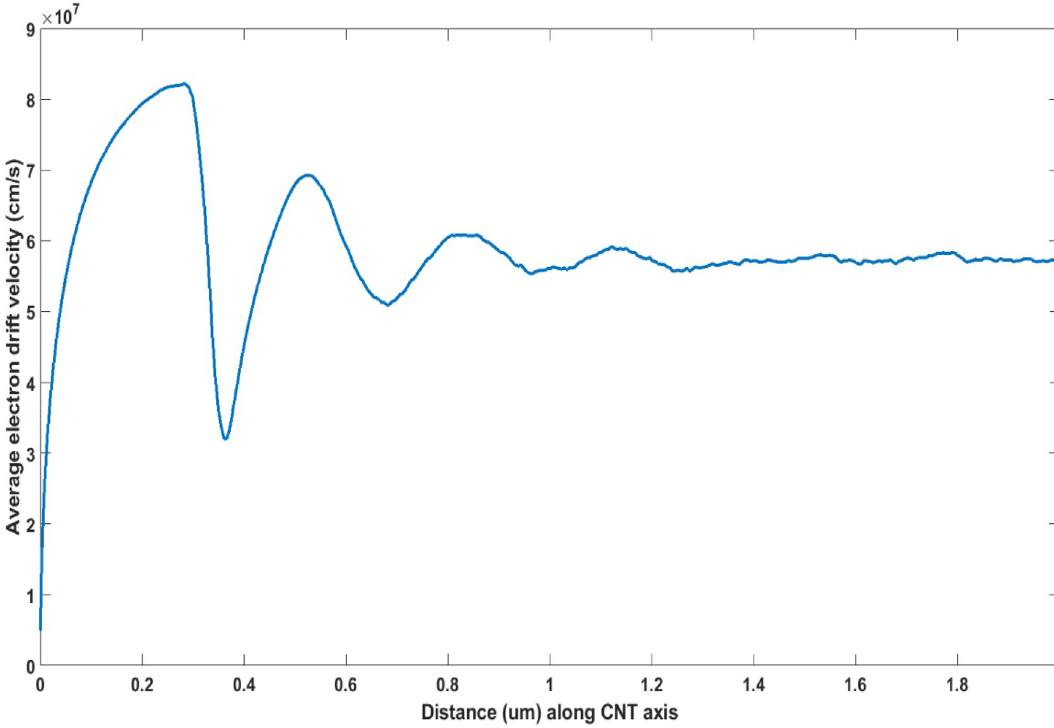
Figure 4. Average electron drift velocity at 5 kV/cm and 4 K versus distance along CNT axis. The velocity oscillations, caused by phonon emission processes, can be seen to be significant over long